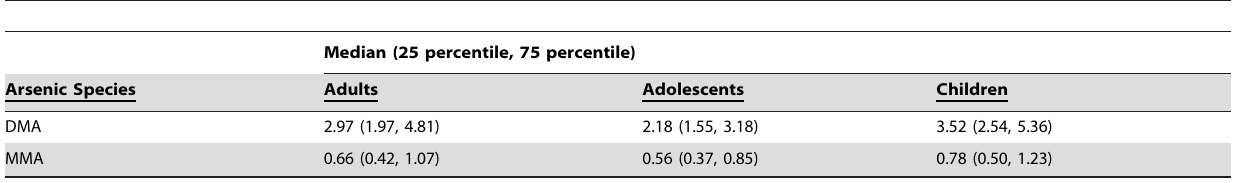
Table 1. Sample-weighted statistics for creatinine-adjusted urinary arsenic species [ m mol/mol Cre] in NHANES 2003–2010 data used in the regression models displayed in Tables 3 and 4.